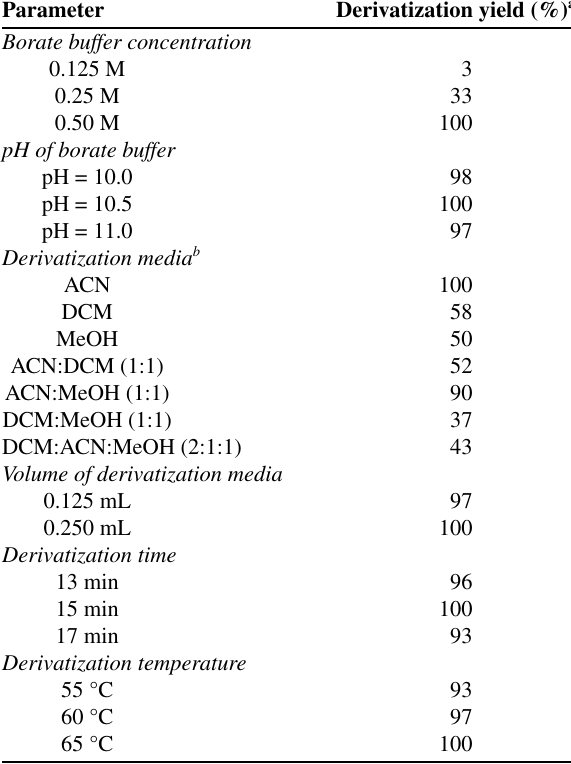
Table 2. Optimization of derivatization parameters